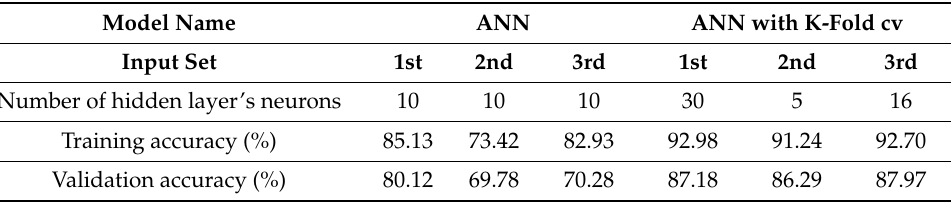
Table 5. Results of ANN